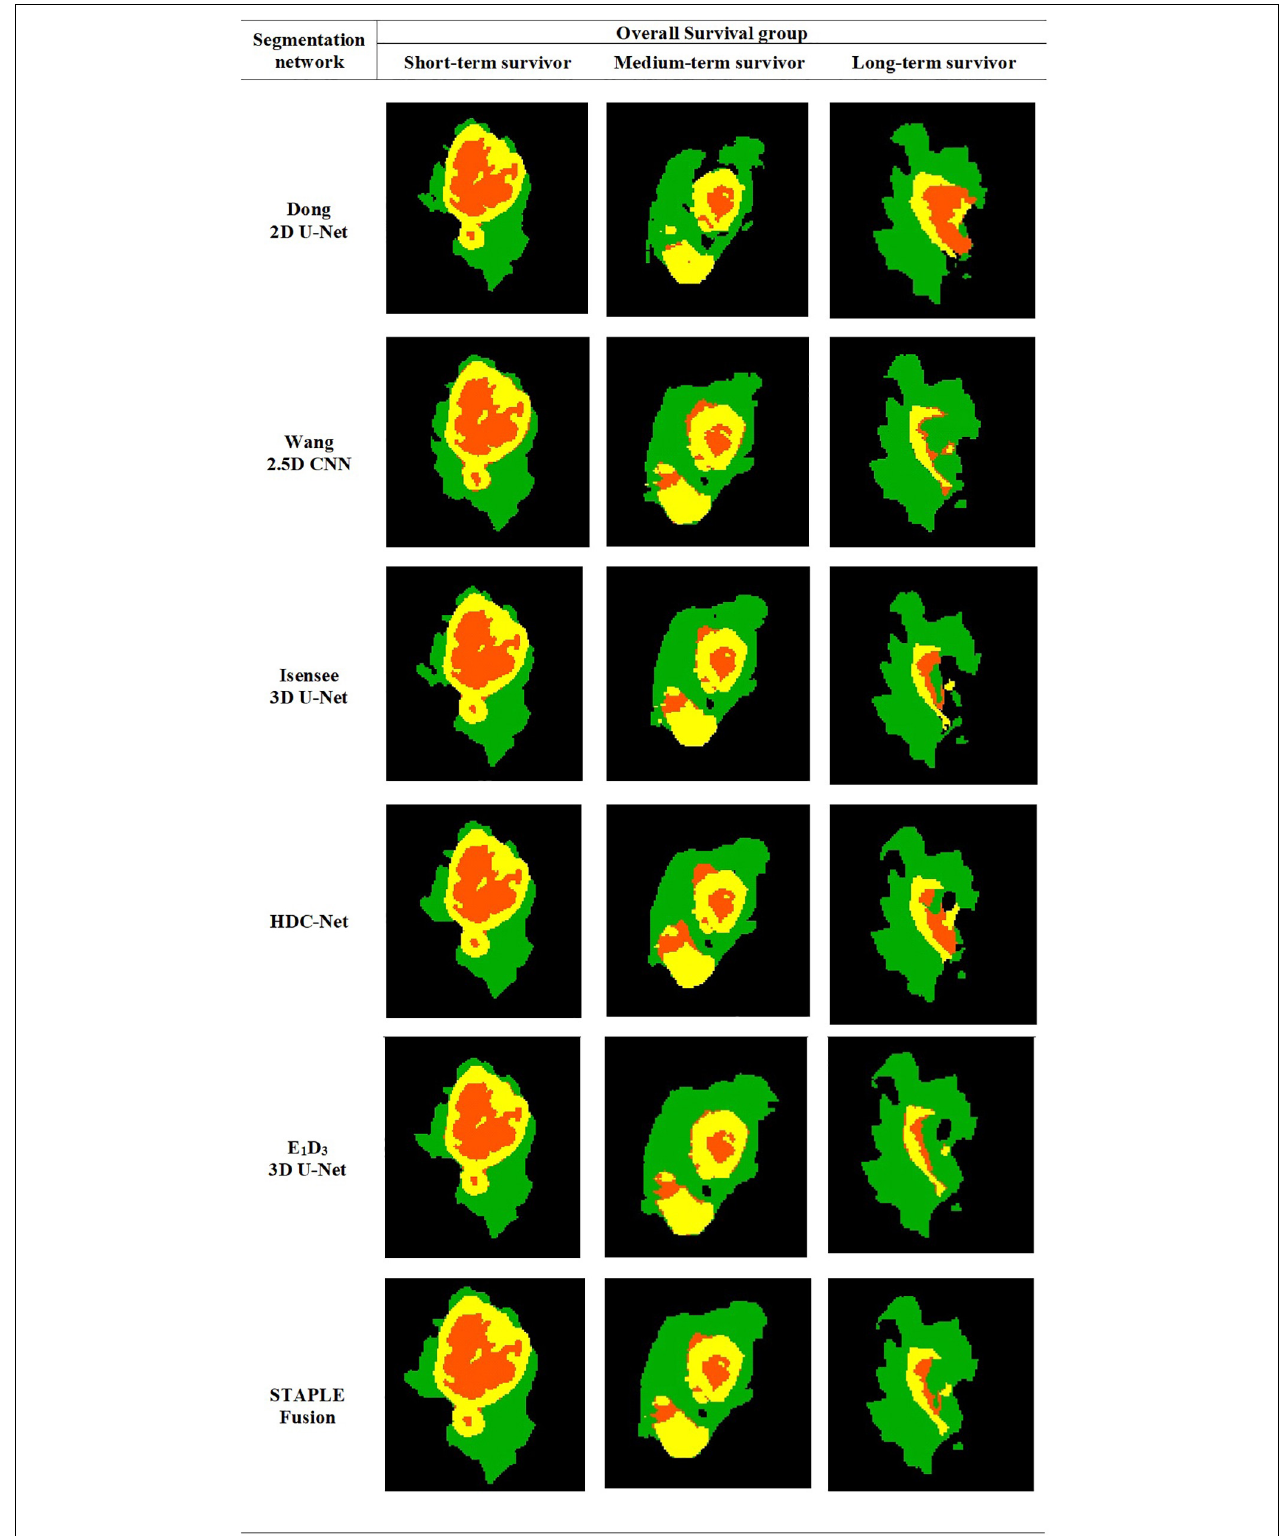
FIGURE 1 | Automatically segmented tumor subregions from six segmentation schemes including five CNNs and one STAPLE fusion method. Peritumoral edema, enhancing core, non-enhancing core. Peritumoral edema (Green) enhancing core (Yellow) and non-enhancing core (Orange).